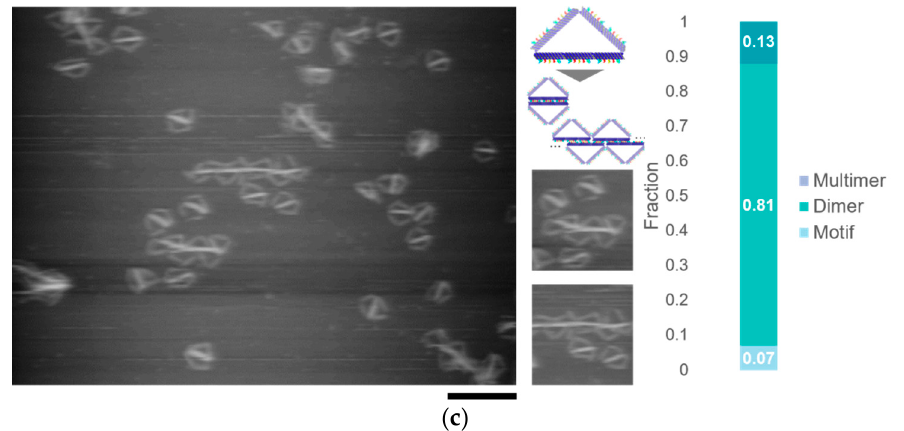
Figure 3. Self-assembly of the motifs with different shapes and connectivity. ( a ) AFM image of dimer formed by the DNA ring motif in flexible state; ( b ) AFM image of dimer formed by the DNA ring motif in triangle (3, 3, 1) state; ( c ) AFM image of dimer and polymer formed by the DNA ring motif in triangle (2, 2, 3) state. Scale bar = 200 nm.